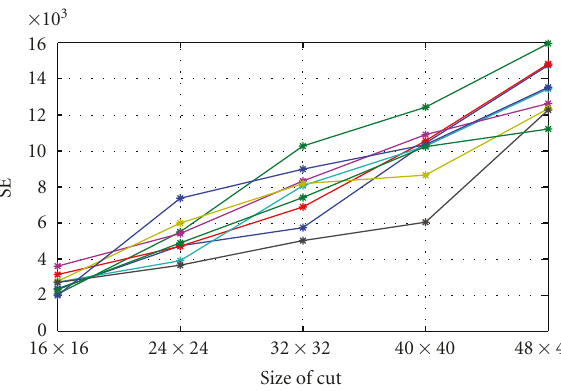
Figure 5: The relationship between distance and the size of cut